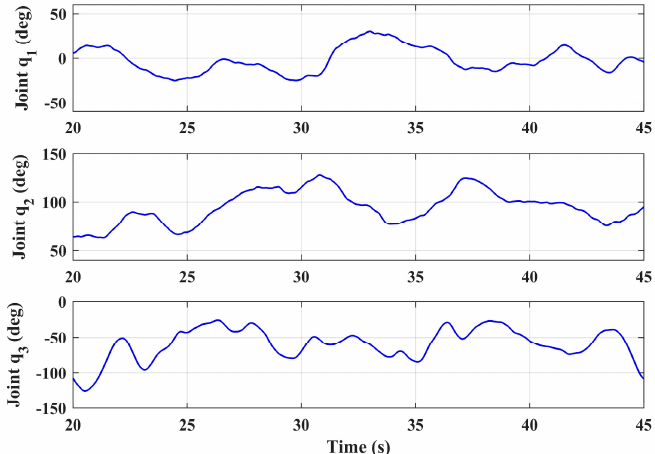
Figure 12. Joint angles in the hovering test.